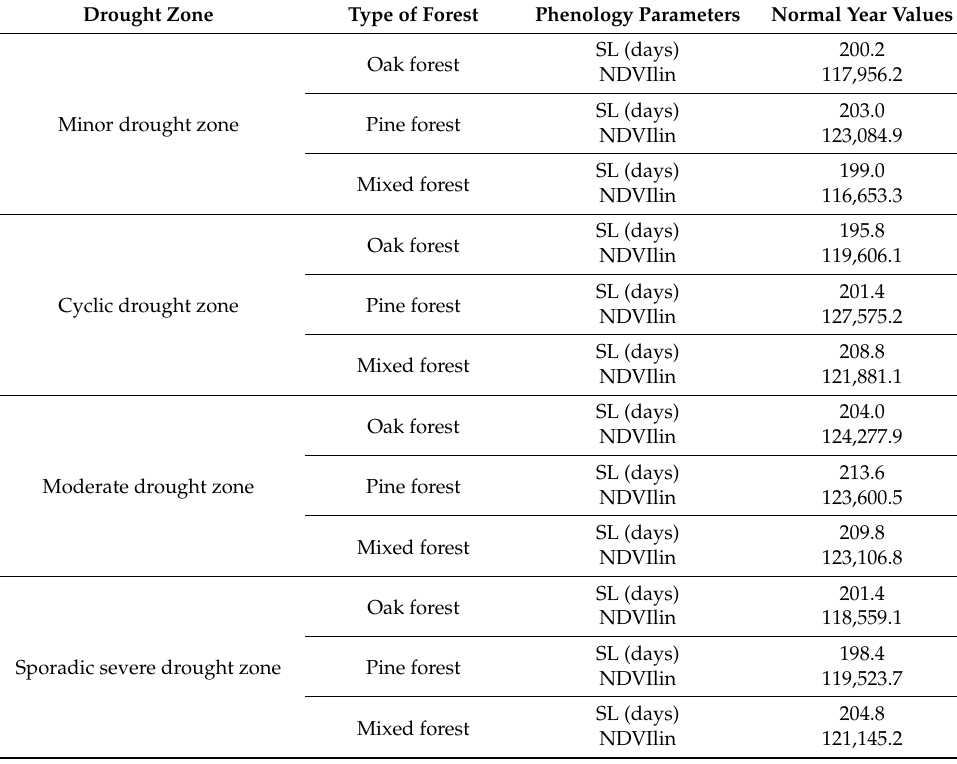
Table A2. Normal year values for SL and NDVIlin for each drought